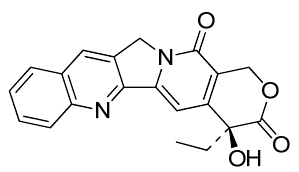
Figure 1. Structure of 20( S